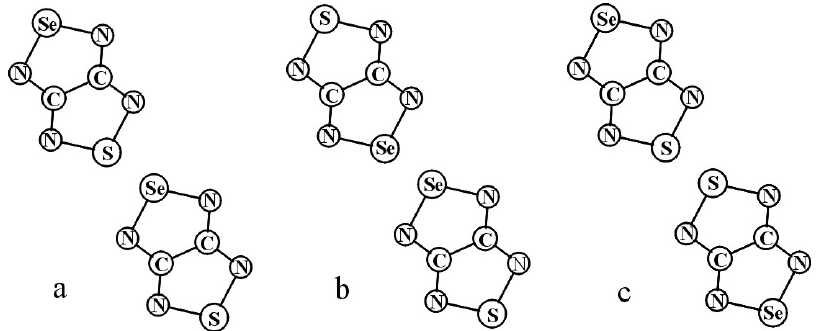
Figure 18. Different orientations of RAs of 26 in their selected pair for salt 71